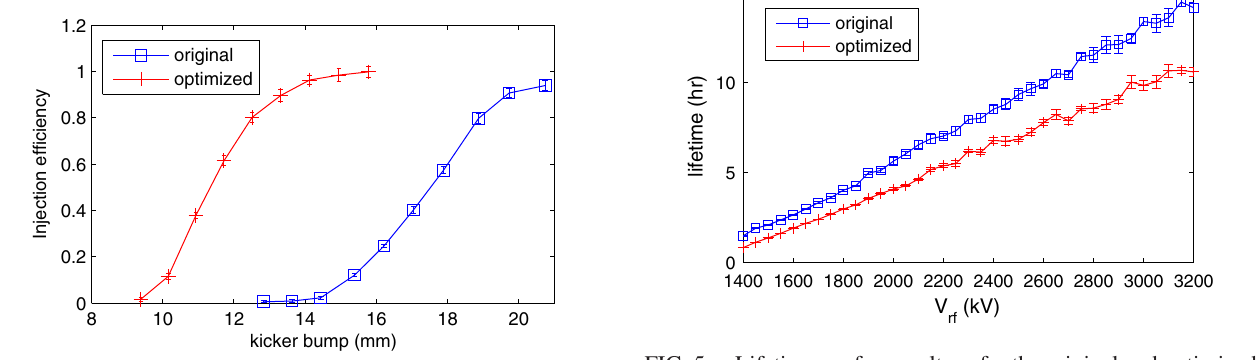
FIG. 4. Injection efficiency vs kicker bump for the original and optimized solutions.